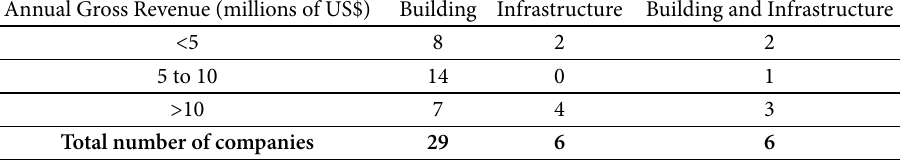
table 1. Number of construction companies that responded the survey according to their annual gross revenue and core business Annual Gross revenue (millions of US$) Building Infrastructure Building and